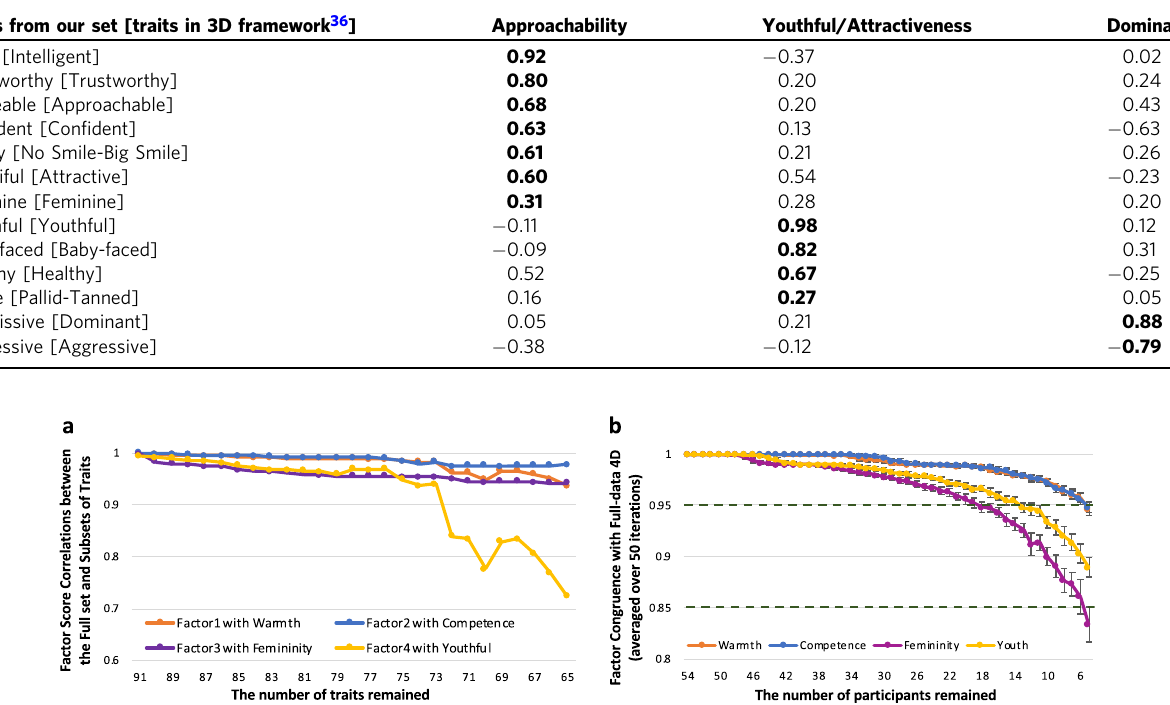
Fig. 5 Robustness of dimensions with respect to the number of traits and participants. a Pearson ’ s correlations between factor scores from the full set versus subsets of traits. Colors indicate the four different dimensions. b Tucker indices of factor congruence (with orthogonal Procrustes rotation) between the full set versus subsets of participants. Colors indicate the four different dimensions. Points indicate the means and error bars indicate standard deviations across the 50 iterations. Source data are provided as a Source Data fi le.